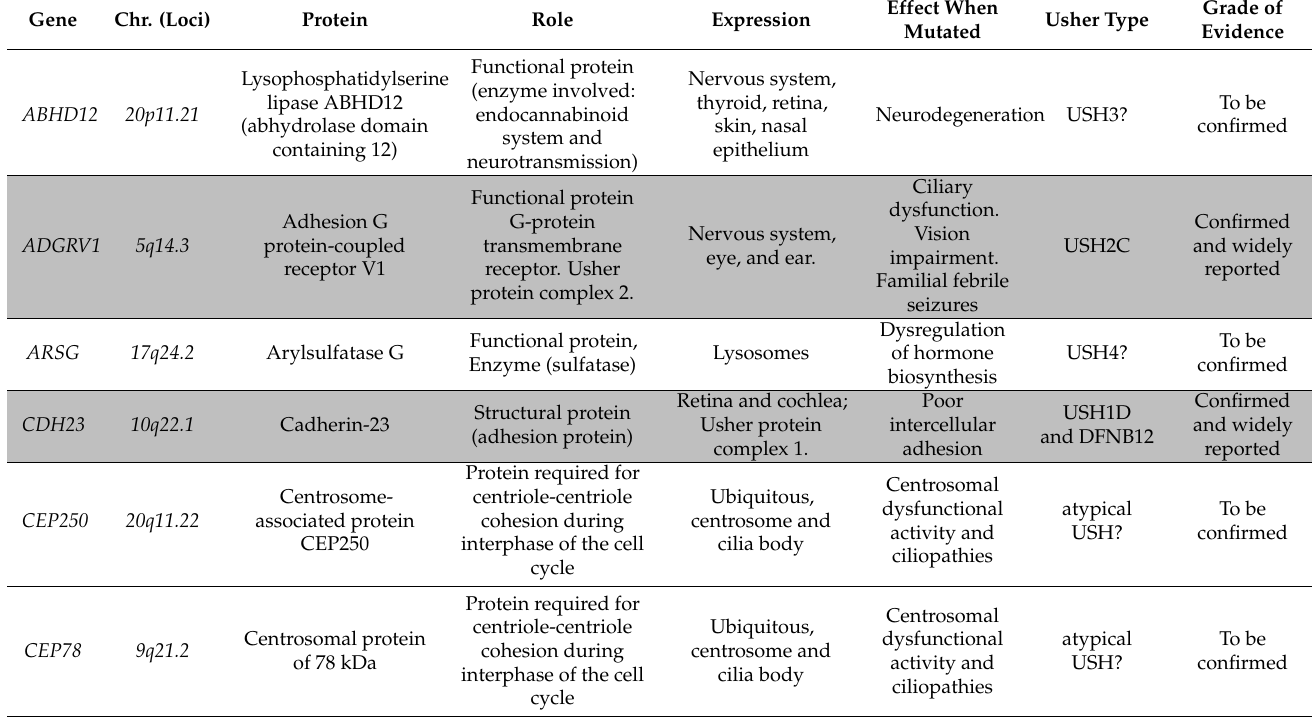
Table 1. Genes potentially involved in Usher syndrome (in alphabetic order): nine confirmed causative genes are reported in grey. Names of proteins and genes have been reported according